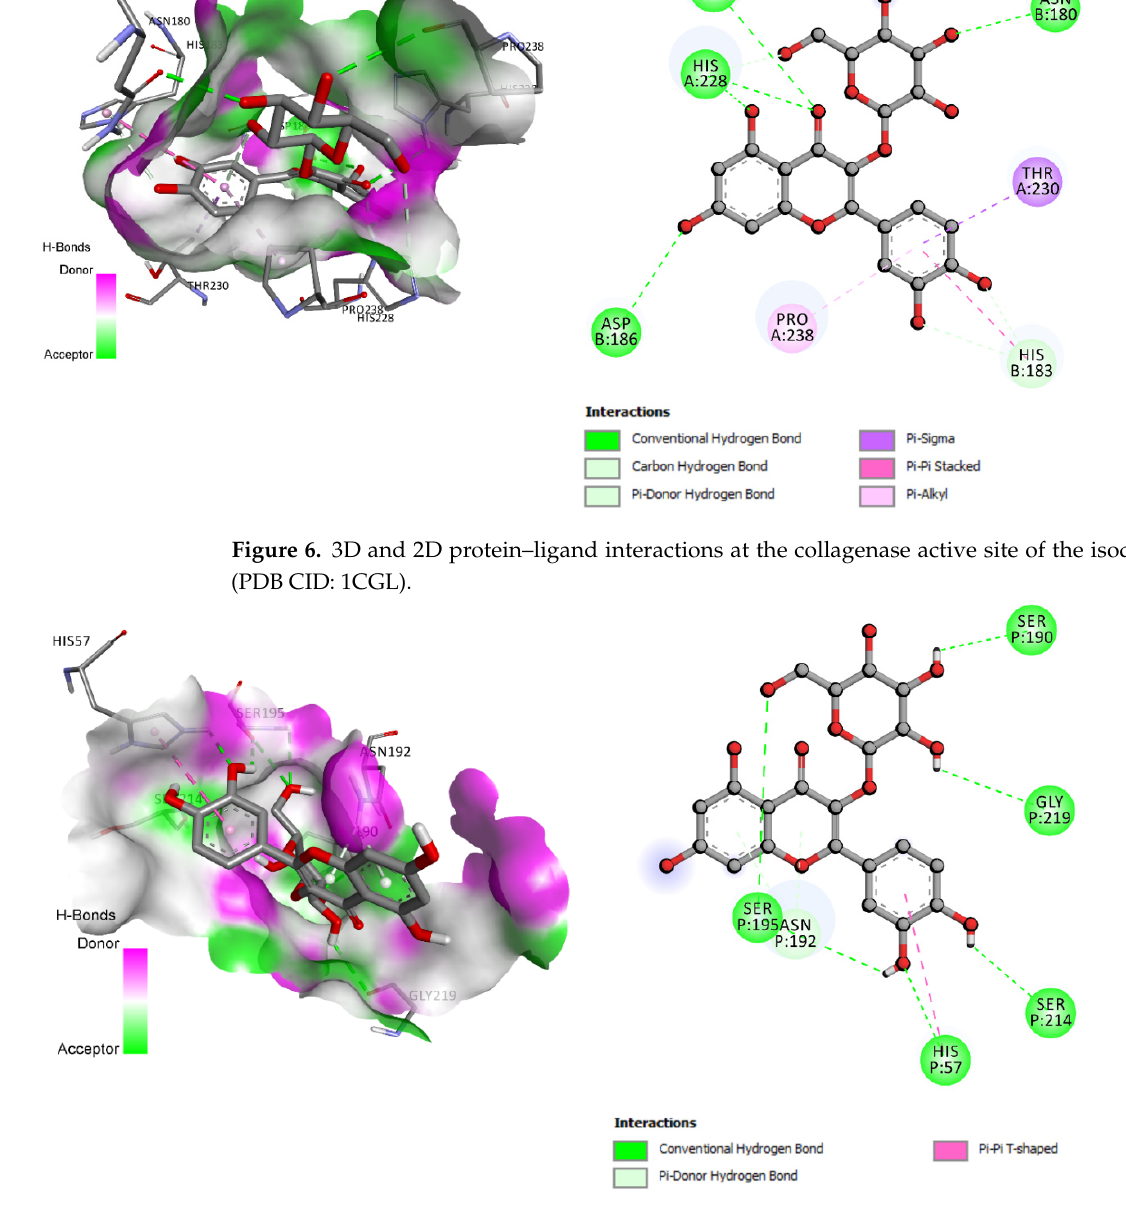
Figure 7. 3D and 2D protein–ligand interactions at the elastase active site of the hyperoside (PDB CID: 1BRU). CID: